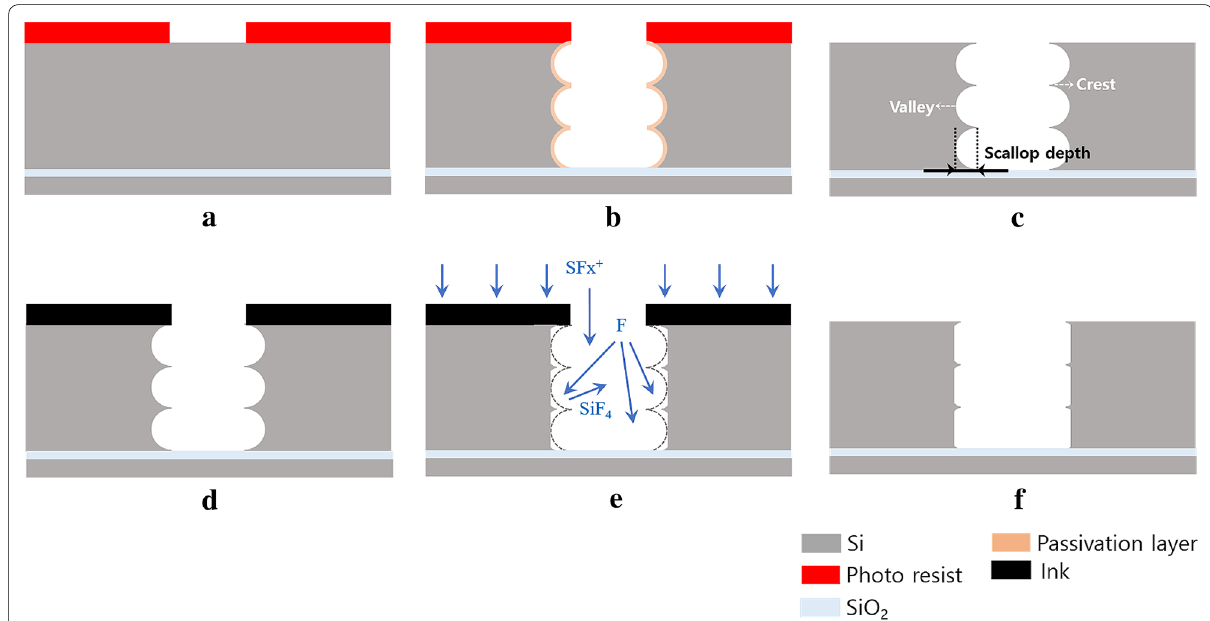
Fig. 1 Experimental process of scallop smoothing of DRIE trench by RIE‑based SF 6 plasmas. This process flow represents a single trench of 64 arrays. a Patterning the photoresist with a circular pattern mask on the silicon handle layer of an SOI wafer. b 230 μm deep DRIE of the silicon handle layer. ( c ) Removing the photoresist on the surface of the handle layer and ashing the passivation layer on the sidewall of the trench. d Transferring black ink onto the silicon surface for masking the surface. e Scallop smoothing using subsequent RIE. f Final smoothened trench after cleaning the black